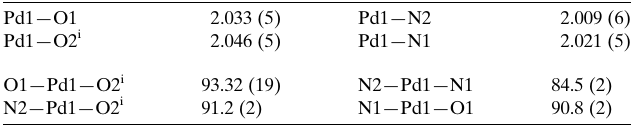
Table 1 Selected geometric parameters (A˚ , (cid:3) ).